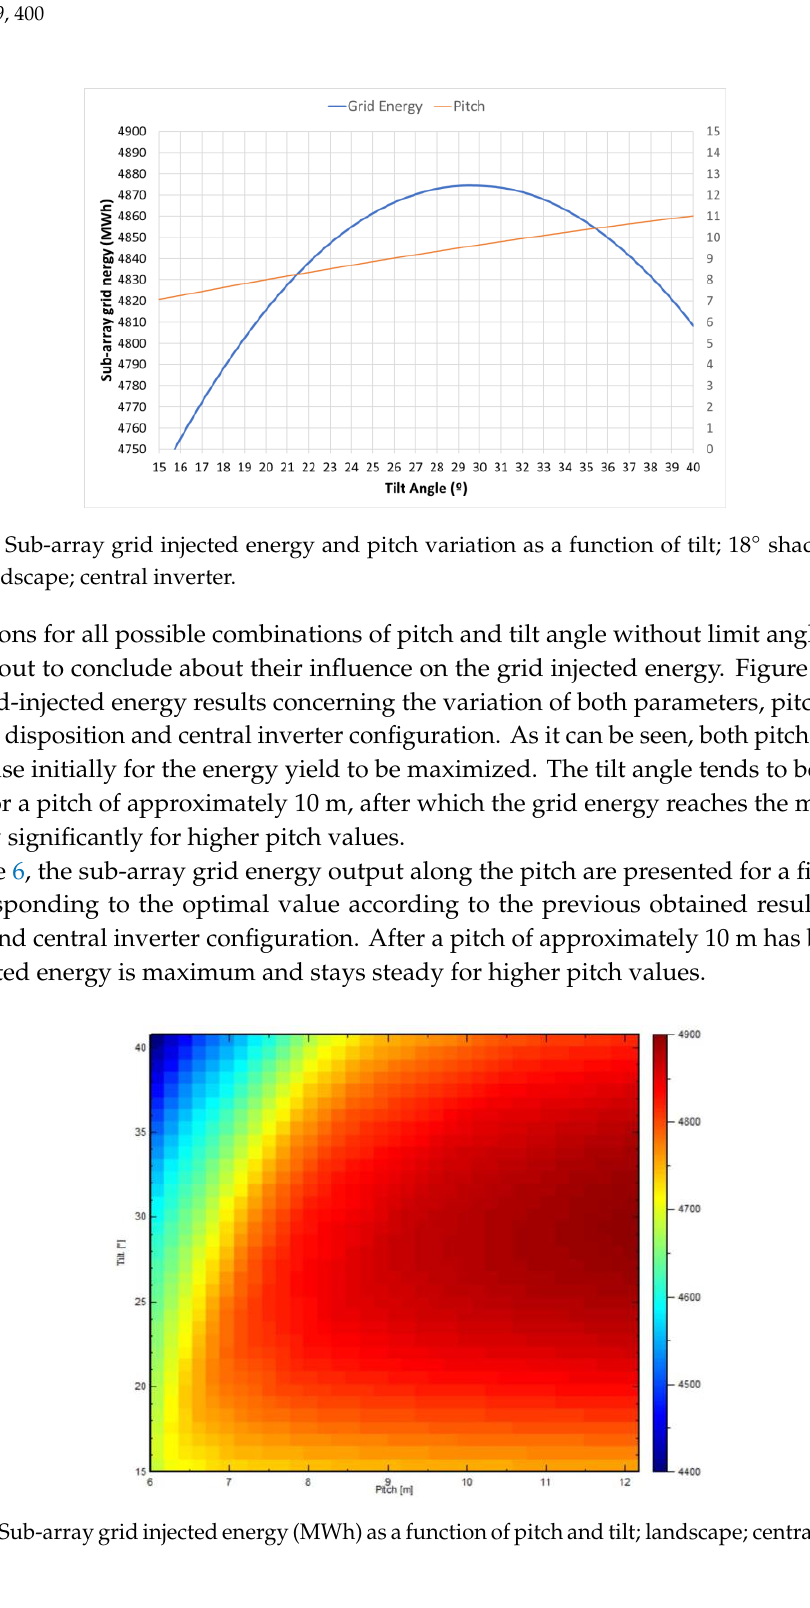
10 of 16 Figure 3. Sub-array grid injected energy as a function of tilt; portrait versus landscape; central inverter; pitch=9.65 m. We note that different string cables’ length are required depending on whether the panels are disposed in portrait or landscape. Thus, no conclusions can be directly drawn from this analysis regarding the most economical viable configuration to employ, as different dispositions lead to different energy outputs but also to different initial investments. Through the pitch and tilt angle, one must ensure that the shadings stemming from adjacent rows are minimized as much as possible. A shading limit angle of 18º was set for no shadings to be produced between 9 and 16 h on December 22 (worst case). Figure 4 depicts the sub-array grid injected energy and the pitch (right scale) as a function of the tilt angle for the landscape disposition and central inverter configuration. If the shading limit angle is to be kept constant, the pitch and tilt angle are dependent on each other. So, a tilt angle increase will be followed by a pitch increase (as can be seen in Figure 4) for the